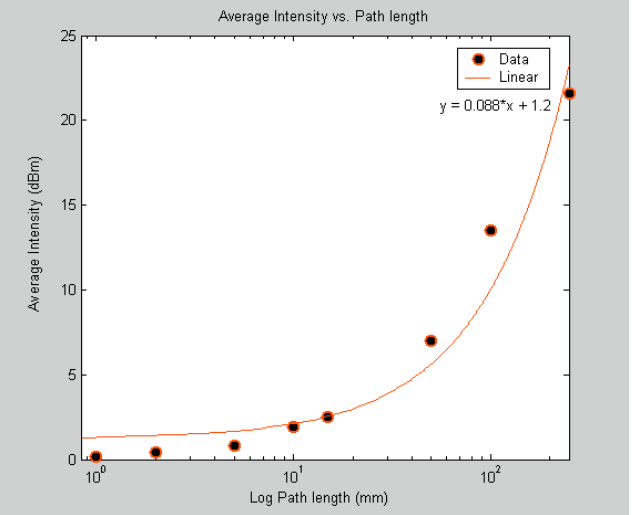
Figure 5. Average Intensity vs. Path length (134 µm bore size) at 20 Psi.